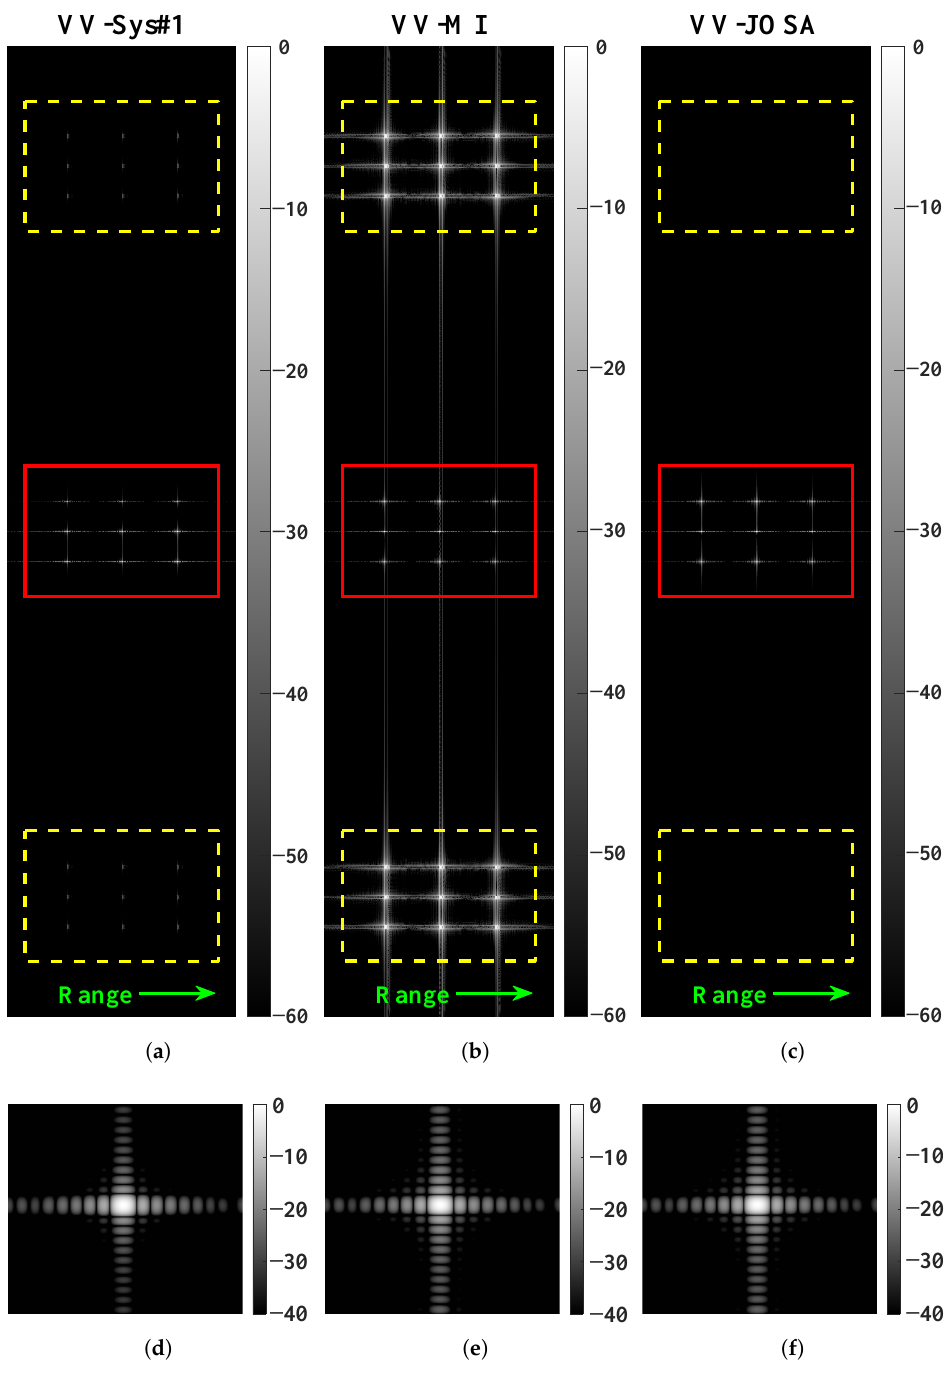
Figure 12. Multi-point imaging results of VV polarization with azimuth ambiguities considered (nine points). System parameters in Table 1 are applied. Amplitude of all the sub-figures is normalized in dB. ( a ) Multi-point simulation result of VV polarization based on system #1 (single-channel ± π /4 quad-pol SAR); ( b ) points simulation result of VV polarization based on system #2 (multichannel ± π /4 quad-pol SAR), reconstructed via the conventional MI method; ( c ) points simulation result of VV polarization based on system #2 (multichannel ± π /4 quad-pol SAR), reconstructed via the proposed JOSA method. Points marked with red solid rectangle in ( a – c ) represent the desired targets, while the points in yellow dashed rectangle represent the fake targets induced by ambiguities. ( d – f ) give the up-sampled imaging results of the desired targets (points in the upper-left corner) in ( a – c ),